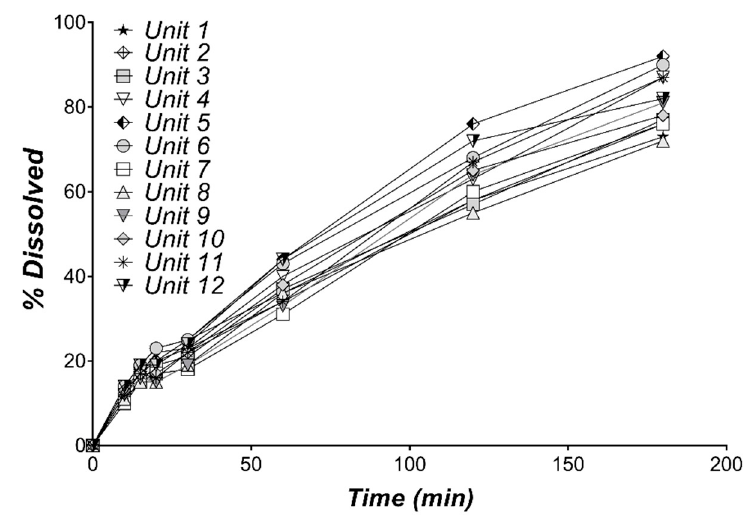
Figure 1. Individual in vitro dissolution profiles of DTZ from 60 mg Cardiazem ® tablets in 900 mL water, using USP Apparatus 2, at 75 rpm ( n = 12). Table 1. In vitro dissolution of DTZ from 60 mg Cardiazem ® tablets in 900 mL water, using USP Apparatus 2, at 75 rpm ( n =